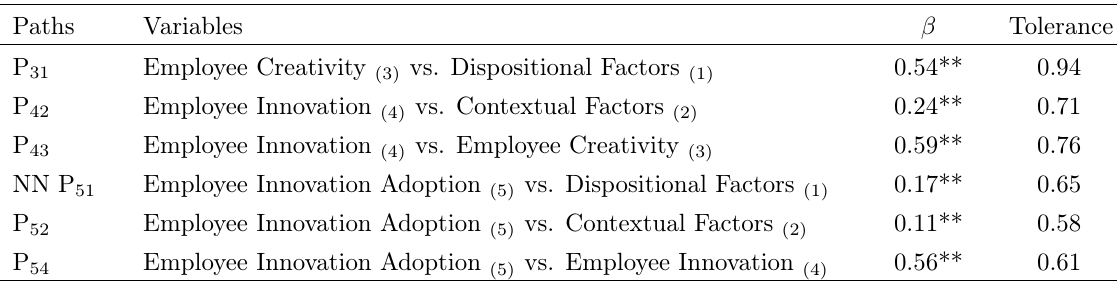
Table 4: Path Coefficients of the Included Paths for the Exogenous and Endogenous Factors in the Hypothesised Model in Figure